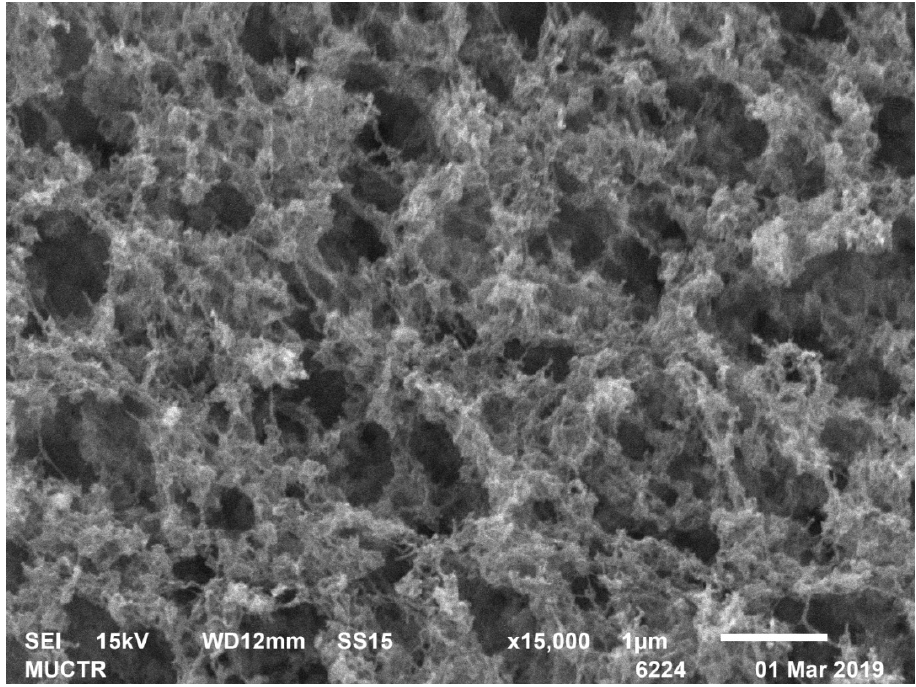
Figure 8. SEM-image of sample 11 chitosan-based aerogel particles.